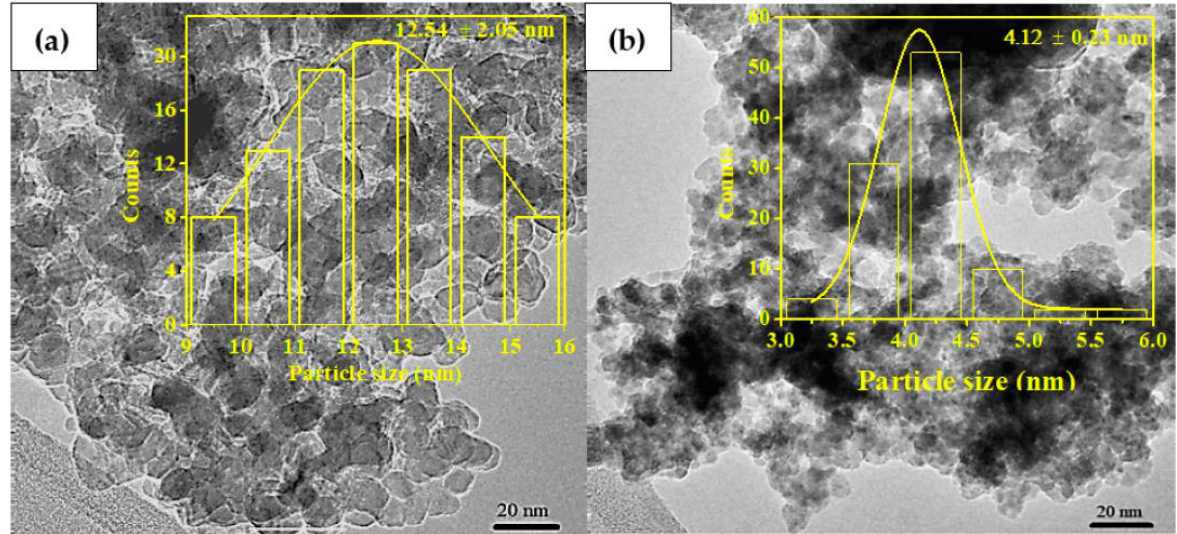
Figure 9. TEM samples of the ( a ) neat ZT and ( b ) ZnO QD. The average particles are represented by the insert. Reprinted from [58].